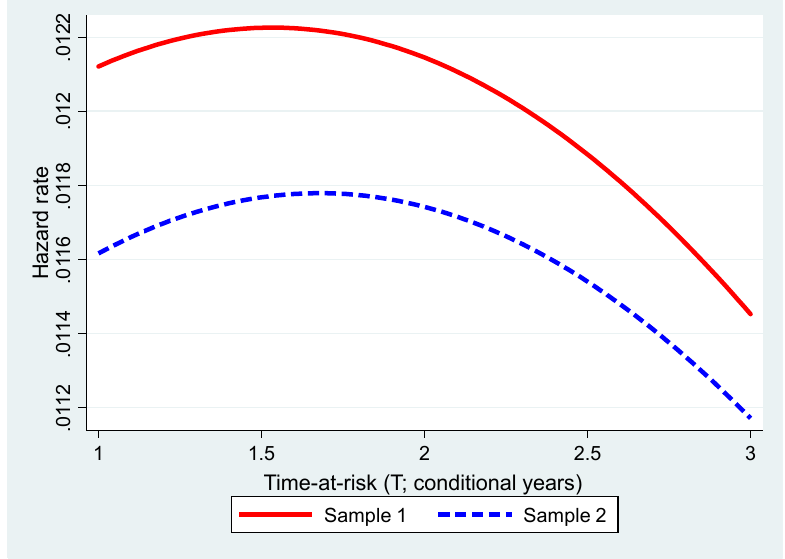
Figure 1. Plots of the hazard rate estimate versus time ‐ at ‐ risk for two sub ‐ samples.